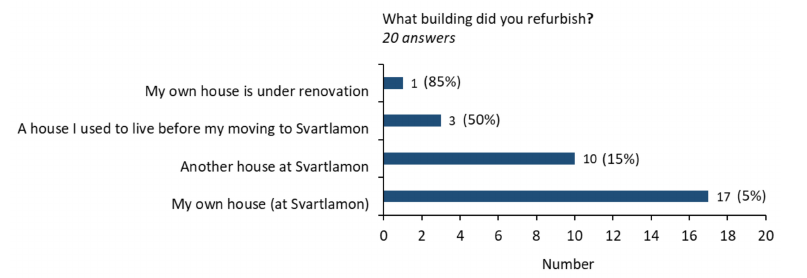
Figure 17. The type of buildings and the participants involvement in renovation plans.